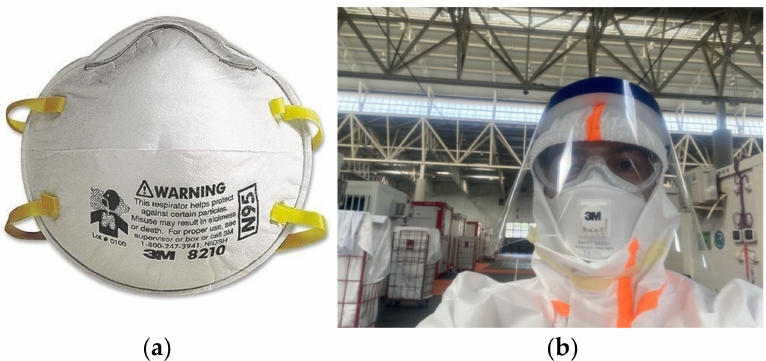
Figure 1. Face masks employed: ( a ) N95 face mask (source: Wikimedia Commons); ( b ) FFP2 face mask wore by a healthcare worker (FM-R), along with the personal protective